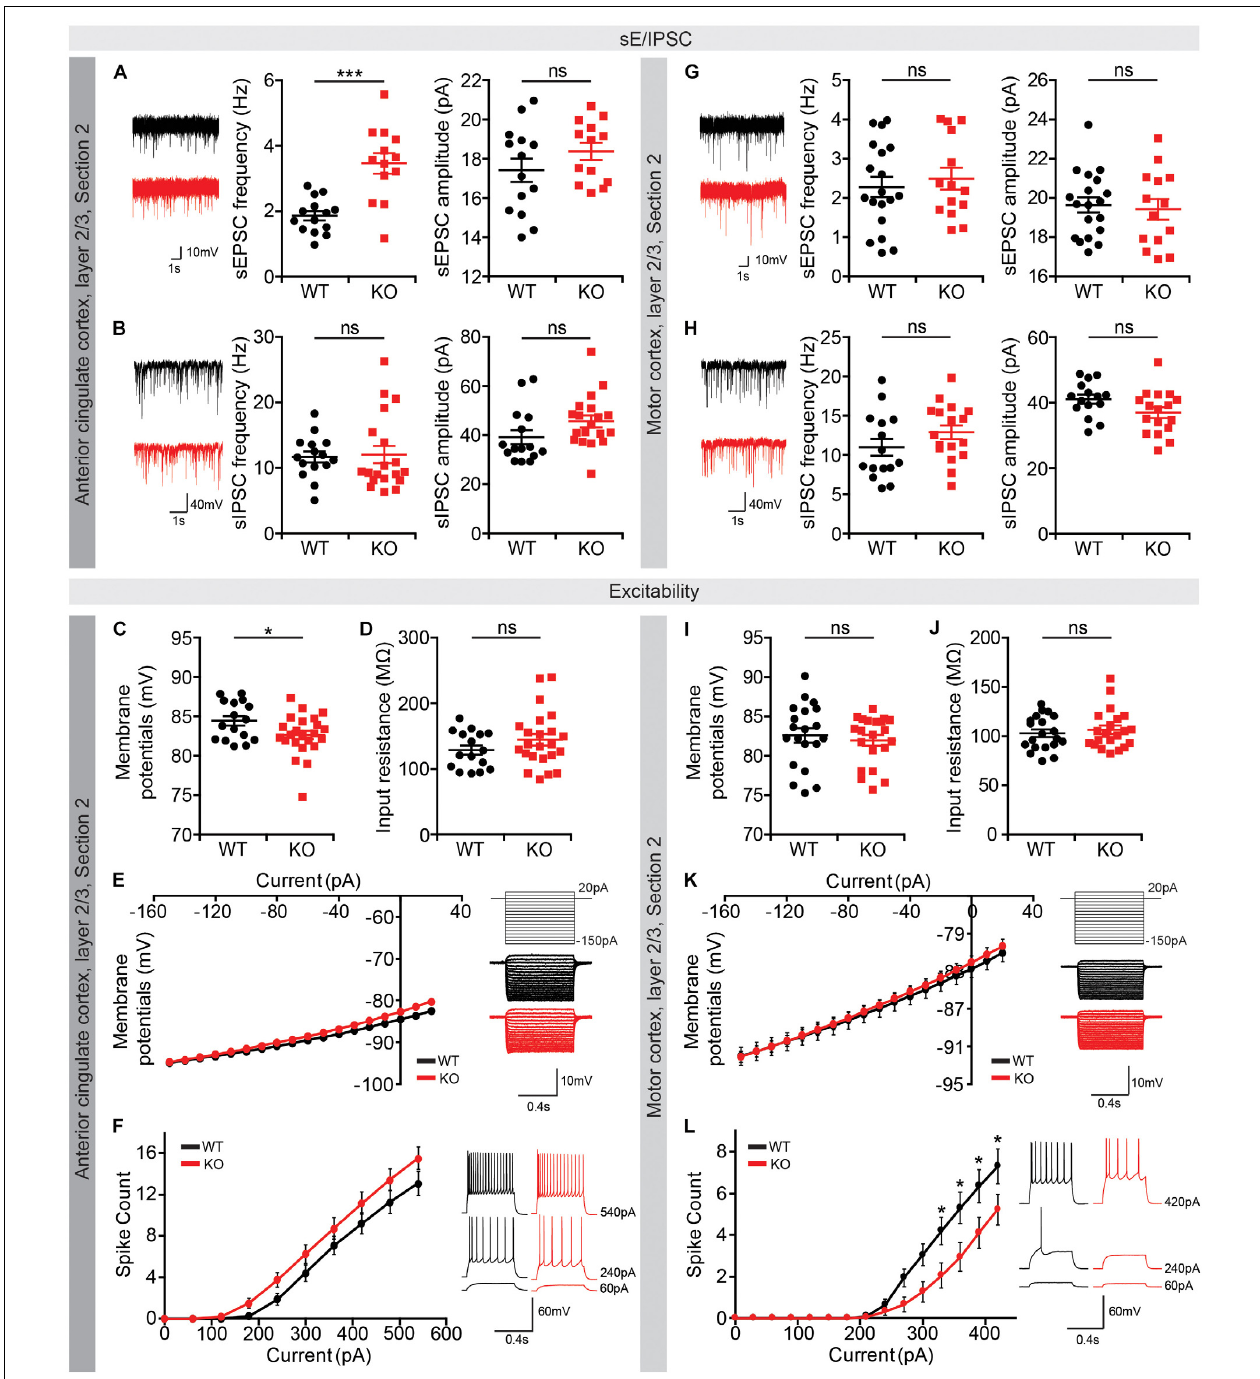
FIGURE 8 | Altered synaptic transmission and intrinsic excitability in the Lrrc4c − / − ACC and MO. (A,B) Increased frequency (but not amplitude) of sEPSCs, and normal sIPSCs in layer 2/3 pyramidal neurons in the ACC of Lrrc4c − / − mice (2–4 months). n = 14 neurons (3 mice) (WT), n = 13 (3) (KO), ∗∗∗ p < 0.001, ns, not significant, Student’s t -test [ (A) sEPSC amplitude: t ( 25 ) = 1.277, p = 0.2133; sEPSC frequency: t ( 25 ) = 4.767, p = 0.0001; (B) sIPSC amplitude: t ( 32 ) = 1.717, p = 0.0956; sIPSC frequency: t ( 31 ) = 0.1636, p = 0.8711]. (C–F) Largely normal intrinsic neuronal activity in layer 2/3 pyramidal neurons in the ACC of Lrrc4c − / − mice (2–4 months), as shown by modestly decreased resting membrane potential, but normal input resistance and current-firing curve. n = 16 (3) (WT), n = 23 (4) (KO), ∗ p < 0.05, ns, not significant, Student’s t -test, two-way repeated measures ANOVA with Holm-Sidak multiple comparison test [ (C) t ( 37 ) = 2.178, p = 0.0359; (D) t ( 37 ) = 1.295, p = 0.2034; (E) interaction, F ( 17 , 629 ) = 2.601, p = 0.0004; genotype, F ( 1 , 37 ) = 1.773, p = 0.1912; current, F ( 17 , 629 ) = 436.1, p < 0.0001; (F) interaction, F ( 9 , 333 ) = 1.512, p = 0.1420; genotype, F ( 1 , 37 ) = 2.249, p = 0.1422; current, F ( 9 , 333 ) = 209.9, p < 0.0001]. (G,H) Normal sEPSCs and sIPSCs in layer